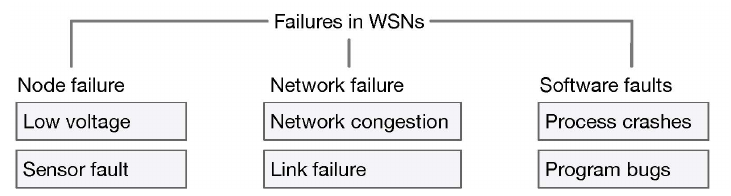
Figure 4. Types of failure in